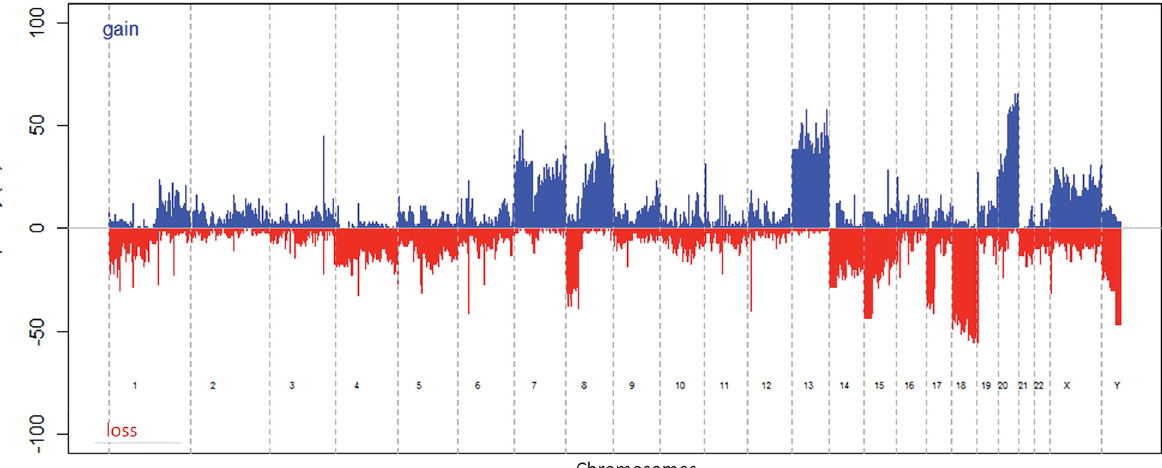
Fig 1. Frequency of DNA copy number alterations of all 93 samples for the whole genome. Gains are represented in blue, losses in